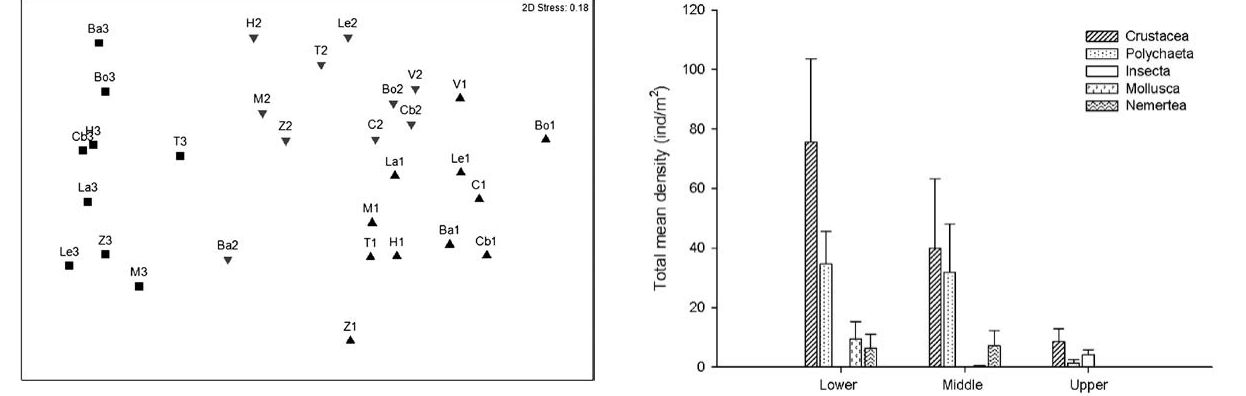
Fig. 3. – n-MDS ordination for the global zonation pattern. Black triangles represent the lower zones, grey inverted triangles the Fig. 4. – Mean total density (±SE) of the taxa found in the lower, middle zones and black quadrates the upper zones of the studied middle and upper zones. beaches.